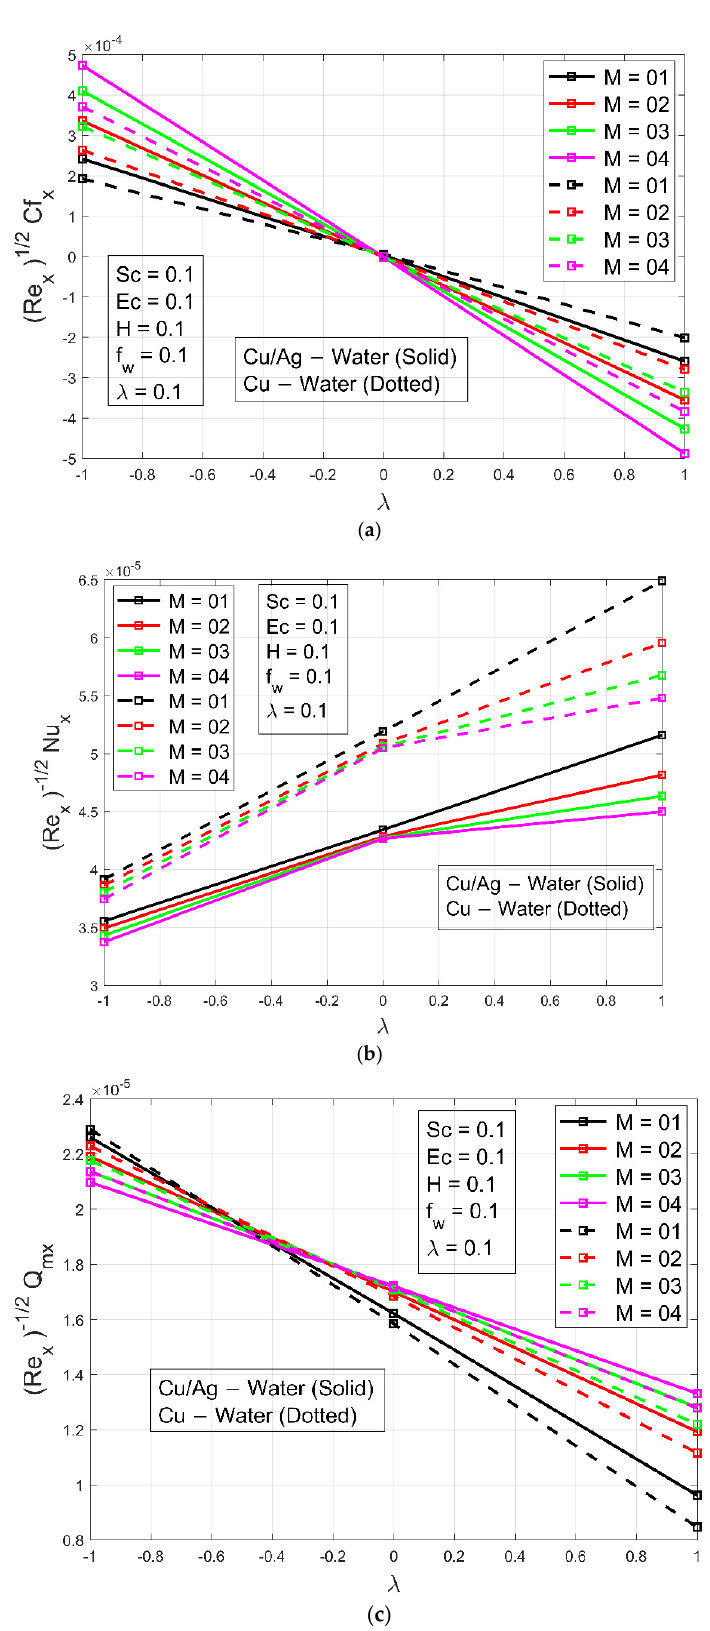
Figure 7. ( a ) Concentration profile 𝜙 ( 𝜂 ) under the impact of Schmidt number 𝑆𝑐 . ( b ) Concentra- tion profile 𝜙 ( 𝜂 ) under the impact of Stefan blowing parameter 𝑓 (cid:3050) . ( c ) Concentration profile 𝜙 ( 𝜂 ) under the impact of Hall parameter 𝐻 .